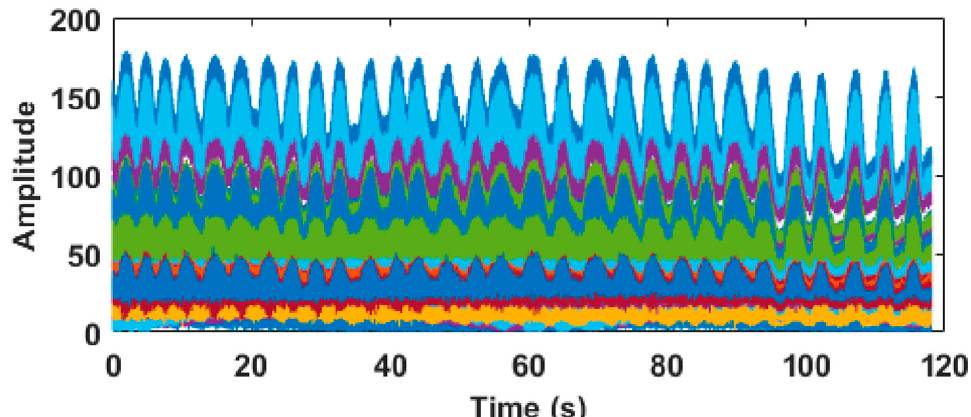
Figure 7. Normal respiration waveform.